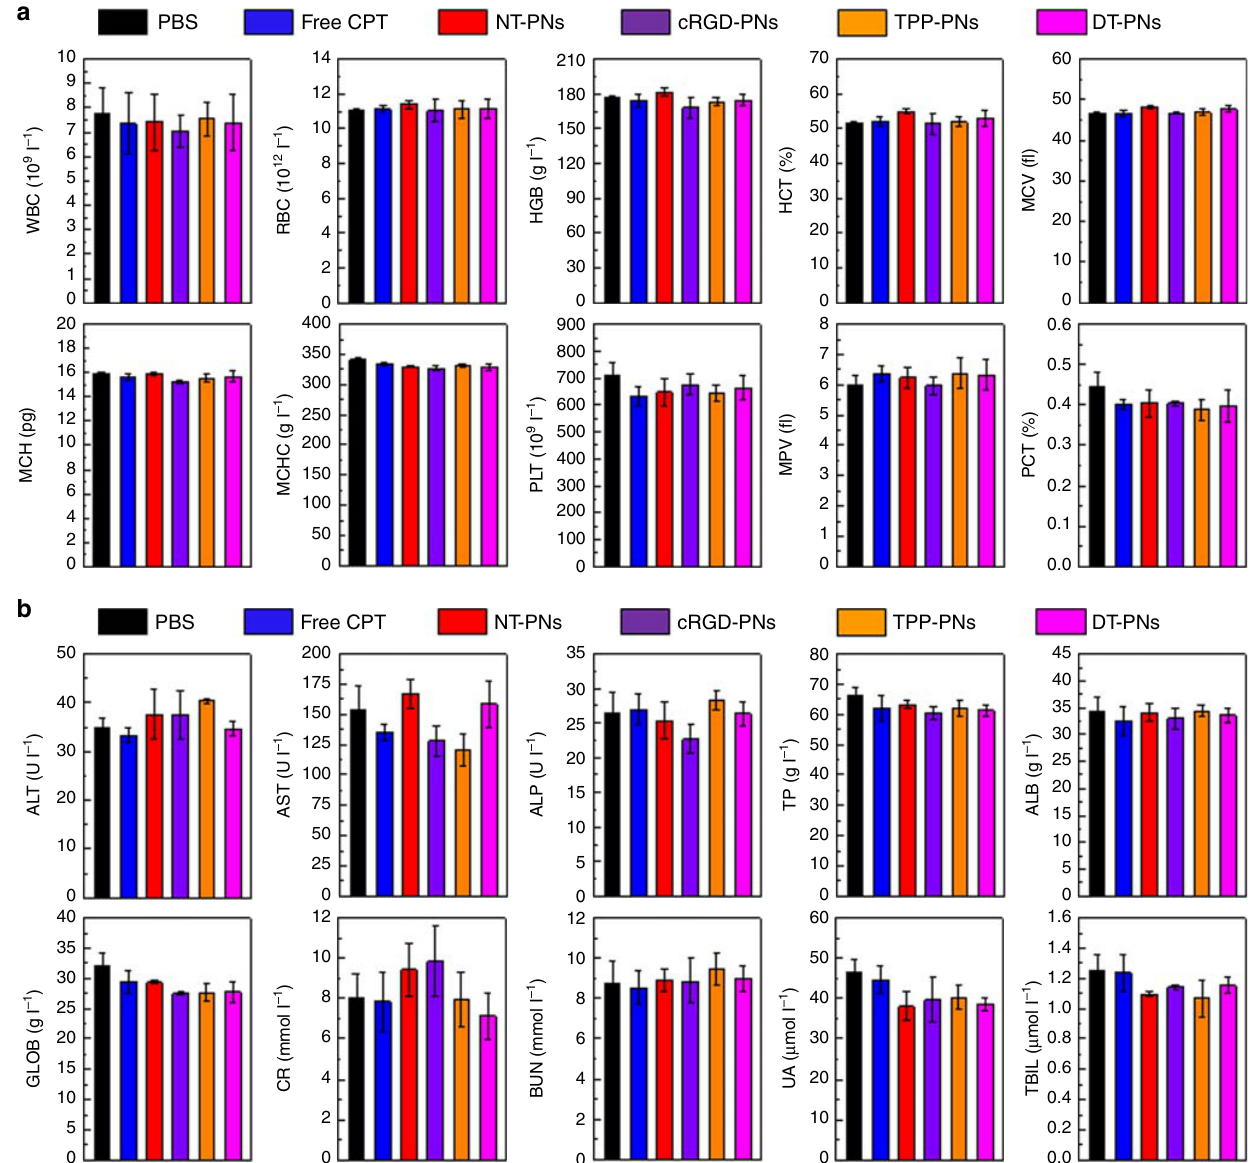
Fig. 9 In vivo side effects evaluation. a Haematological data of the mice intravenously injected with different samples at the 21st day post-injection. The terms are noted as followed: white blood cells (WBC), red blood cells (RBC), haemoglobin (HGB), haematocrit (HCT), mean corpuscular volume (MCV), mean corpuscular haemoglobin (MCH), mean corpuscular haemoglobin concentration (MCHC), platelets (PLT), mean platelet volume (MPV), and thrombocytocrit (PCT). b Blood biochemical analysis at the 21st day post-injection. The terms are following: alanine transaminase (ALT), aspartate transaminase (AST), alkaline phosphatase (ALP), total protein (TP), albumin (ALB), globulin (GLOB), creatinine (CR), blood urea nitrogen (BUN), uric